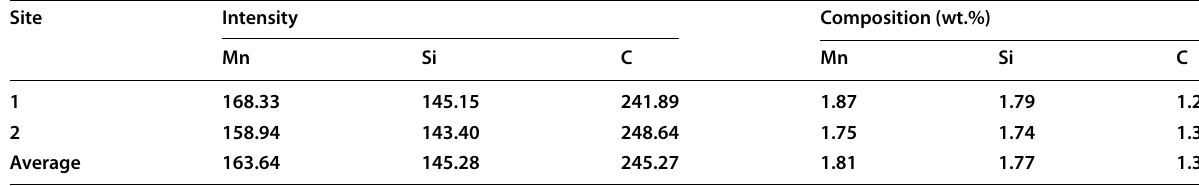
Table 2 The X‑ray intensity and the quantified compositions of the retained γ Site Intensity Composition